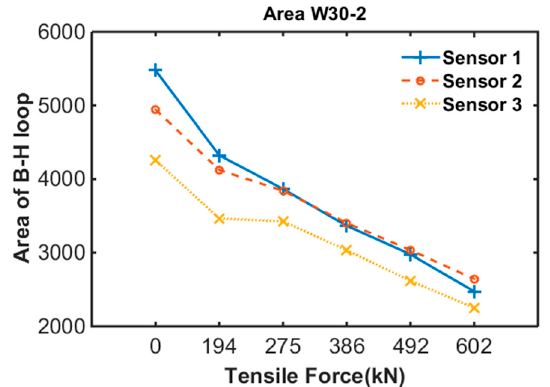
Figure 10 . B-H loop of specimen 2 .